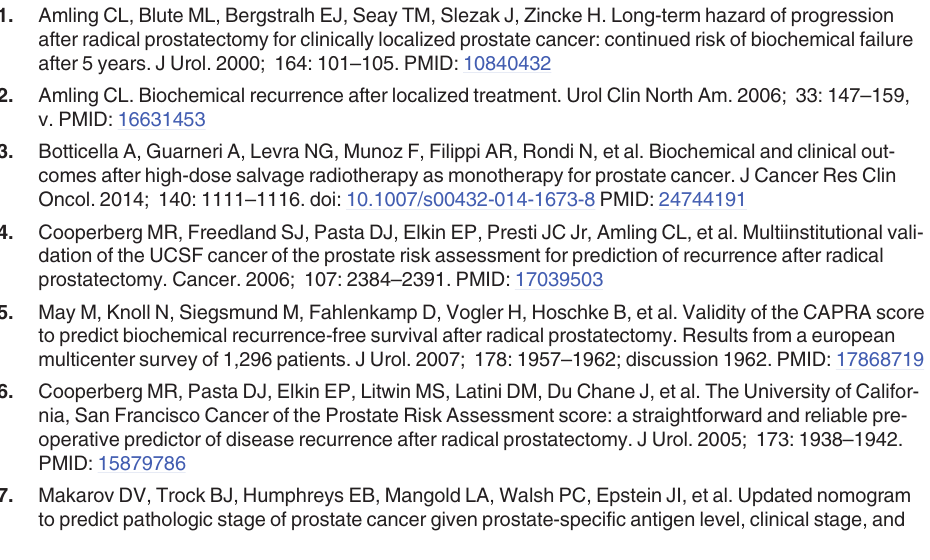
S10 Table. Top 10 putative gene targets and function for miR-4516. Ten genes with the low- est scores and highest probability of being targeted by miR-4516 according to TargetScan are listed with their known gene functions. S11 Table. Ingenuity Pathway Analysis (IPA) was performed on the 88-miRNA signature associated with time to first biochemical recurrence. Displayed are top networks, diseases and disorders, and molecular and cellular functions. S12 Table. Ingenuity Pathway Analysis (IPA) was performed on the 9-miRNAs associated with biochemical recurrence post-salvage radiation therapy. Displayed are top networks and diseases and